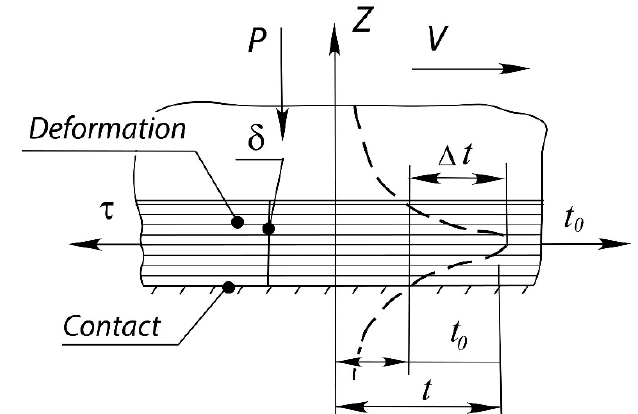
Figure 5. The change in temperature t along the normal surface z to the friction surface (in the deformed surface layer) of metallic friction element: layer ( t ); initial ( t H ); increments ( ∆ t ); environment ( t 0 ); shear stresses ( τ ); surface layer ( δ ); sliding speed ( ν ); and z —the origin of the coordinate axis is located on the middle surface of the